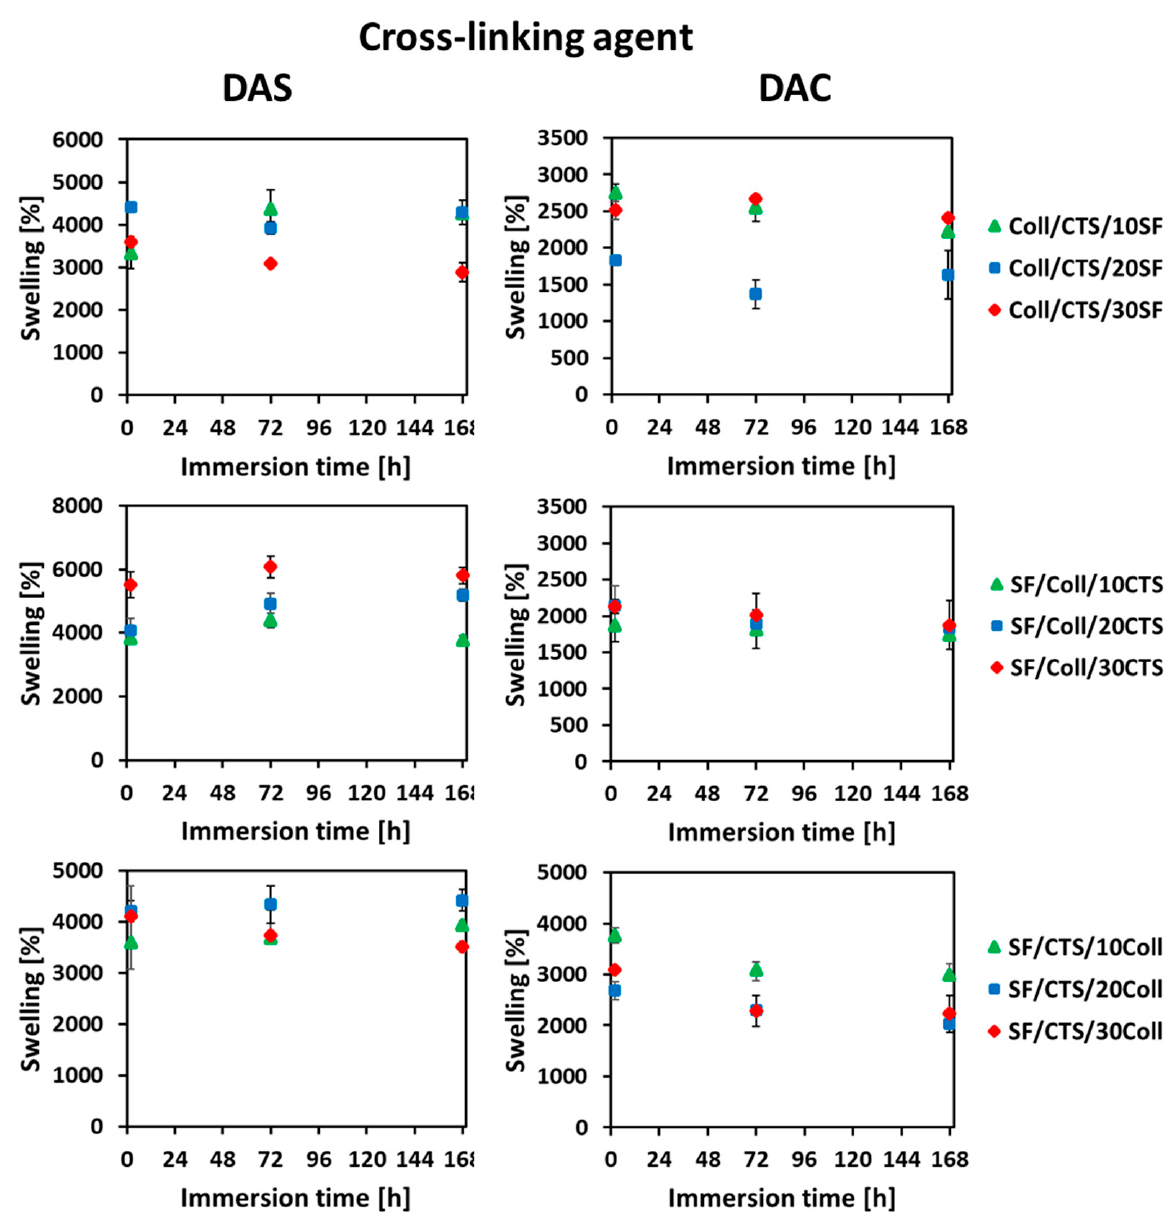
Figure 6. The results of swelling ratio determination of the scaffolds cross-linked with dialdehyde starch (DAS, left side) and dialdehyde chitosan (DAC, right side). Results were presented as mean ± standard error of the mean ( n = 3).